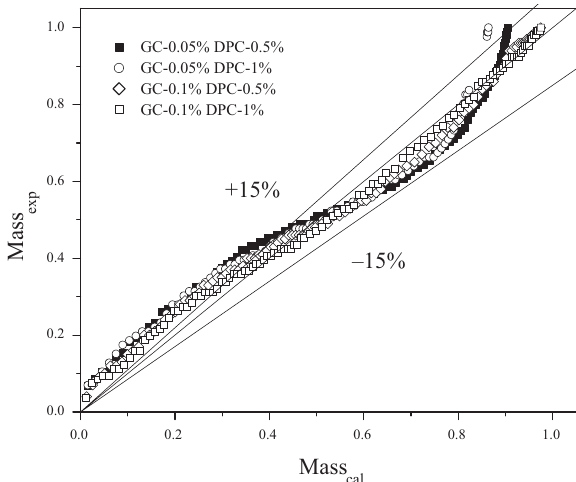
Fig. 7. Correlation between experimental values (massexp) and calculated (masscal) by means of the modified Washburn equation (entire process with gelatin content of 0.5% and 1%)